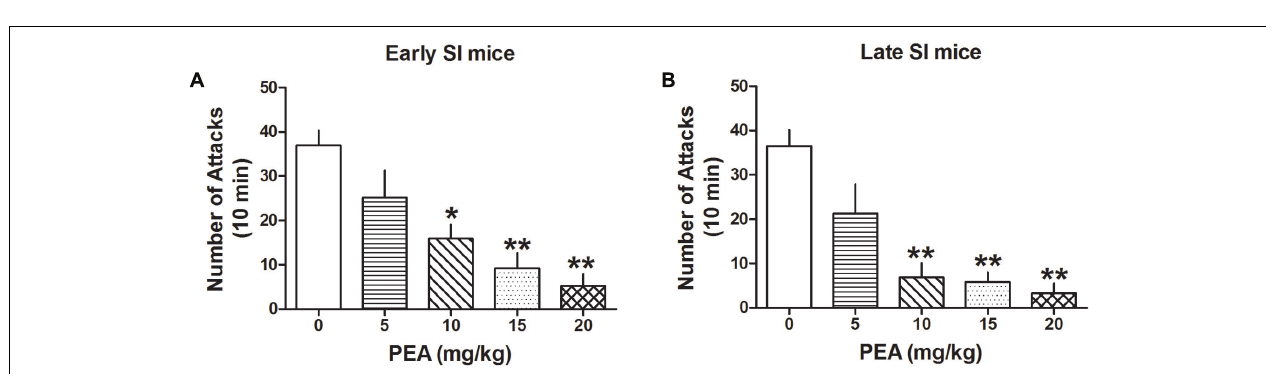
FIGURE 4 | The analog of Allo, BR351 and BR297 decrease aggressive behavior in early and late adolescent SI mice. BR351 at the doses of 1, 2.5, and 5 mg/kg was administered both to early (A) and late (B) adolescent SI mice 60 min before the exposure to a resident–intruder test. Only the dose of 5 mg/kg improved aggression of SI mice with higher potency in late (EC 50 = 3.75 mg/kg) than early (EC 50 = 4.5 mg/kg) adolescent SI mice. BR297 at the doses of 0.3125, 0.625, and 2.5 mg/kg was administered both to early (C) and late (D) adolescent SI mice 60 min before the exposure to a resident–intruder test. Dose-response data analyses showed that BR297 was equally potent in decreasing aggression of early and late adolescent SI mice with an EC 50 dose of 0.25 mg/kg. Data represent the mean ± SEM of 10–16 mice. ∗ p < 0.05; ∗∗ p < 0.01; ∗∗∗ p < 0.001, when compared with basal control levels of aggression.